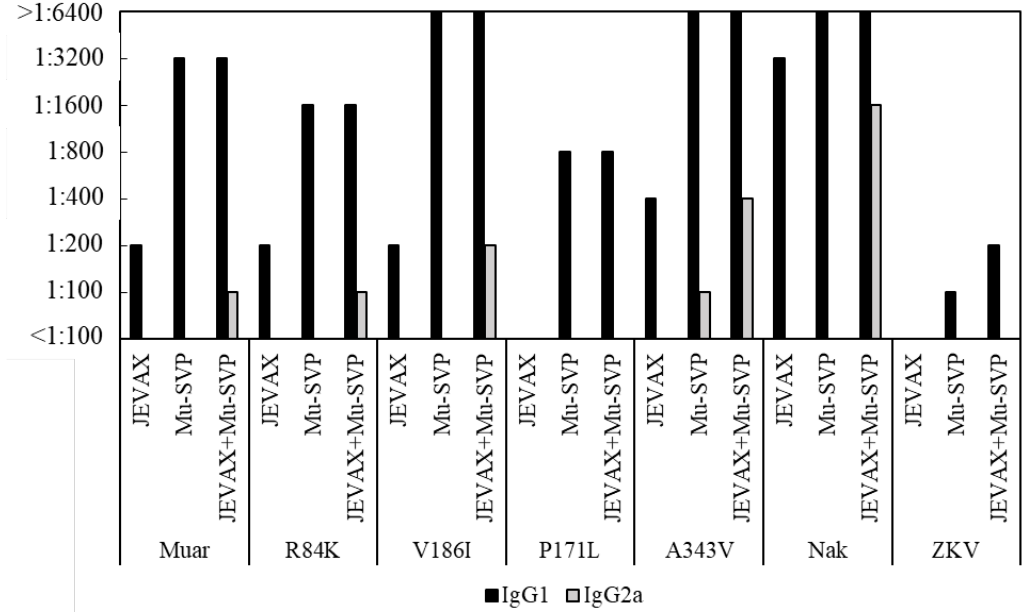
Figure 4. The Th1/Th2 immune profile induced by JEVAX and/or Muar-derived subviral particle (Mu-SVP). The serial two-fold diluted pooled mouse sera (start from 1:100) were examined on the antigen-sensitized plates. SVPs (Muar, R84K, V186I, P171L, A343V, Nak, and ZKV) were used as antigens. Antibody titers of IgG1 (Th2) and IgG2a (Th1) of each group were determined as the highest serum dilution exhibiting optical density (O.D.) greater than average O.D. plus three times the standard deviation obtained by saline inoculated mouse sera.